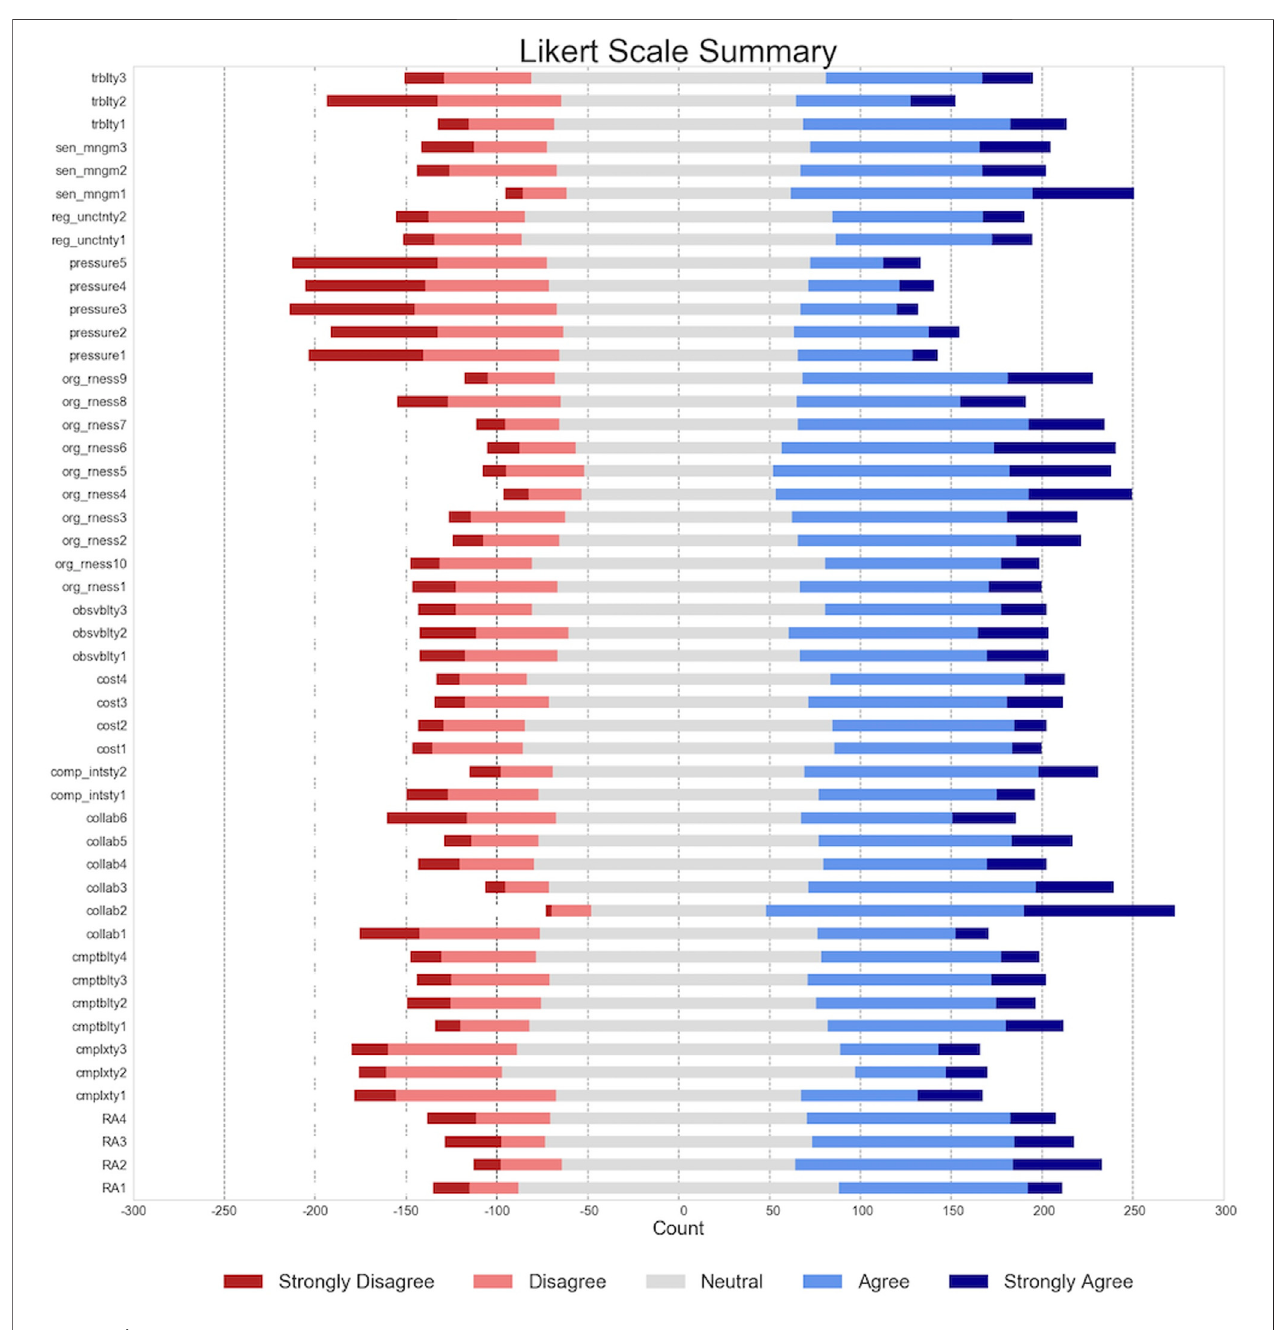
FIGURE A1 | Overview on all the answers.